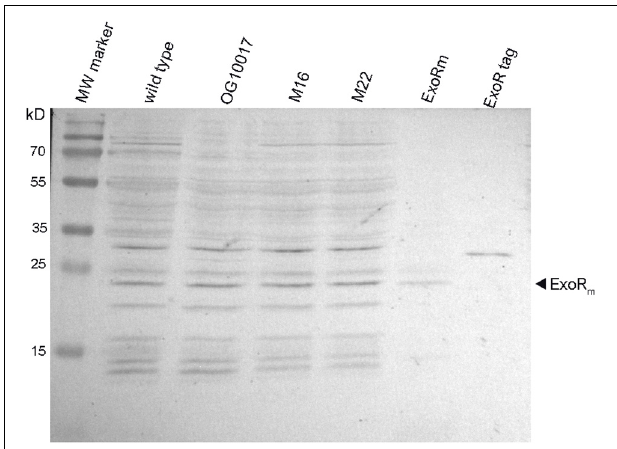
FIGURE 10 | Levels of mature ExoR m are similar in Sinorhizobium meliloti wild type and in PC-deficient mutants. Western blot detection of ExoR protein after electrophoretic separation of extracts from S. meliloti wild type, OG10017, M16, M22 strains, an extract of E. coli BL21(DE3) strain overexpressing ExoR m (ExoRm), and purified ExoR p with an N-terminal His-tag (ExoR tag). For estimation of molecular weights for distinct ExoR versions, a molecular weight (MW) marker (PageRuler Prestained Protein Ladder, Thermo Fisher Scientific) was